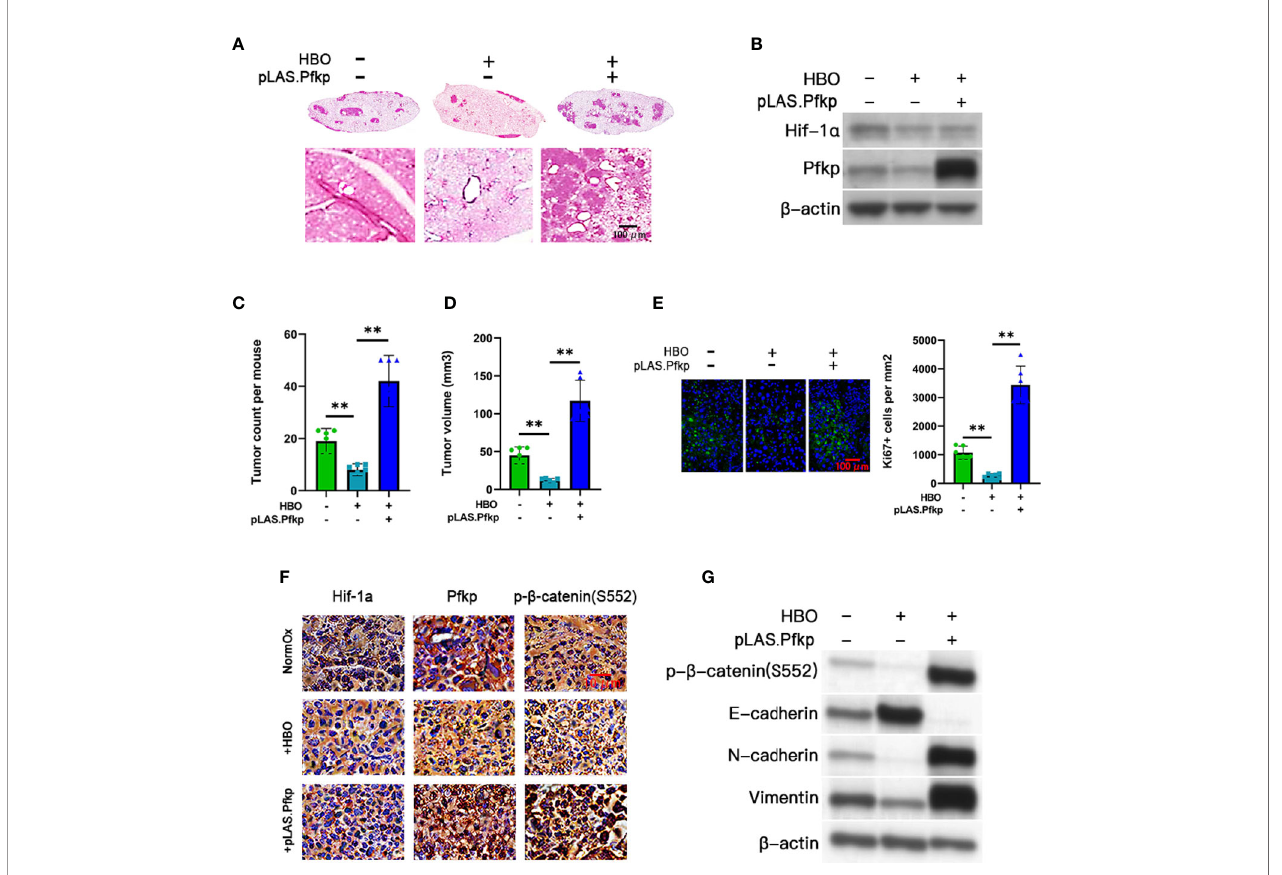
FIGURE 4 | HBO therapy inhibits tumorigenesis in vivo in a Pfkp-dependent manner. Three cohorts were created in Lewis lung carcinoma (LLC) mice: (i) normoxic (NormOx) controls (n = 6), (ii) hyperbaric oxygen (HBO) therapy only (n = 6), and (iii) HBO therapy + pLAS.Pfkp (n = 6). (A) Representative images of hematoxylin and eosin (H&E)-stained whole lung sections (top) and higher-magni fi cation lung sections (×400) (bottom). Scale bar = 100 m m. (B) Immunoblotting validation of Hif-1 a and Pfkp. (C) LLC tumor counts and (D) mean LLC tumor volumes in each cohort. (E) Representative immuno fl uorescent images (×200) of Ki-67 (green)/Hoechst 33342 (blue) staining in LLC tumor sections and associated quanti fi cation of Ki-67+ cell counts per mm 2 for each cohort. Scale bar = 100 m m. (F) Representative immunohistochemistry of Hif-1 a , Pfkp, and p- b -catenin (S552) in LLC tumor sections (×100). Scale bar = 10 m m. (G) Immunoblotting of p- b -catenin (S552), E-cadherin, N-cadherin, and vimentin in LLC tumors. Data represented as means ± SDs. * P < 0.05, ** P < 0.01 [one-way